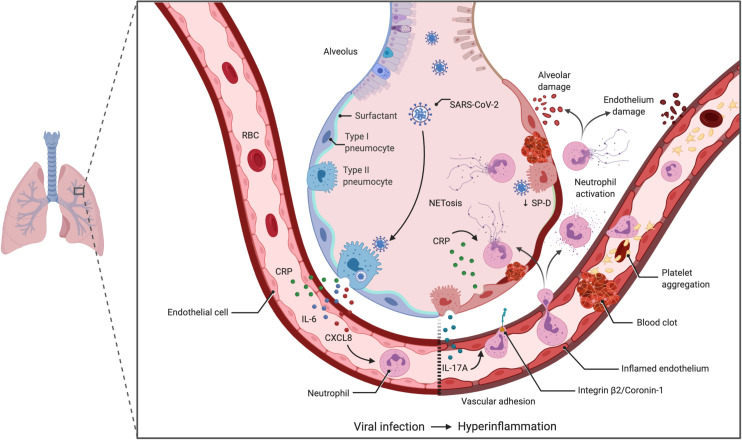
Model of NET-mediated endothelial damage contributing to pulmonary vascular thrombosis in severe COVID-19.Infection by SARS-CoV-2 in vulnerable population will lead to hyperinflammation either from underlying genetic mutations, specific epigenetic landscapes or external factors, that will result in the increase circulation of acute phase reactants such as CRP and pro-inflammatory cytokines associated with neutrophilia like IL-6, IL-17A/F and CXCL8 (IL-8). IL-17A activates the endothelium to induce neutrophil adhesion [105], where the increase in CRP can trigger the release of NETs, resulting in damage to the endothelium as well as aggregation and activation of platelets. Additionally, the presence of SARS-CoV-2 E protein in type II pneumocytes could disturb the surfactant cargo via its interaction with AP3B1, leading to impaired secretion of SP-D and greater NET formation by septal and intra-alveolar neutrophils increasing the risk of thrombosis in the pulmonary microvasculature. In some predisposed patients the combinations of these mechanisms will lead to severe COVID-19 complications. The identification of mediators of this pro-coagulation cascade is essential in achieving the two-fold task of identifying vulnerable populations and developing a personalized medicine approach.